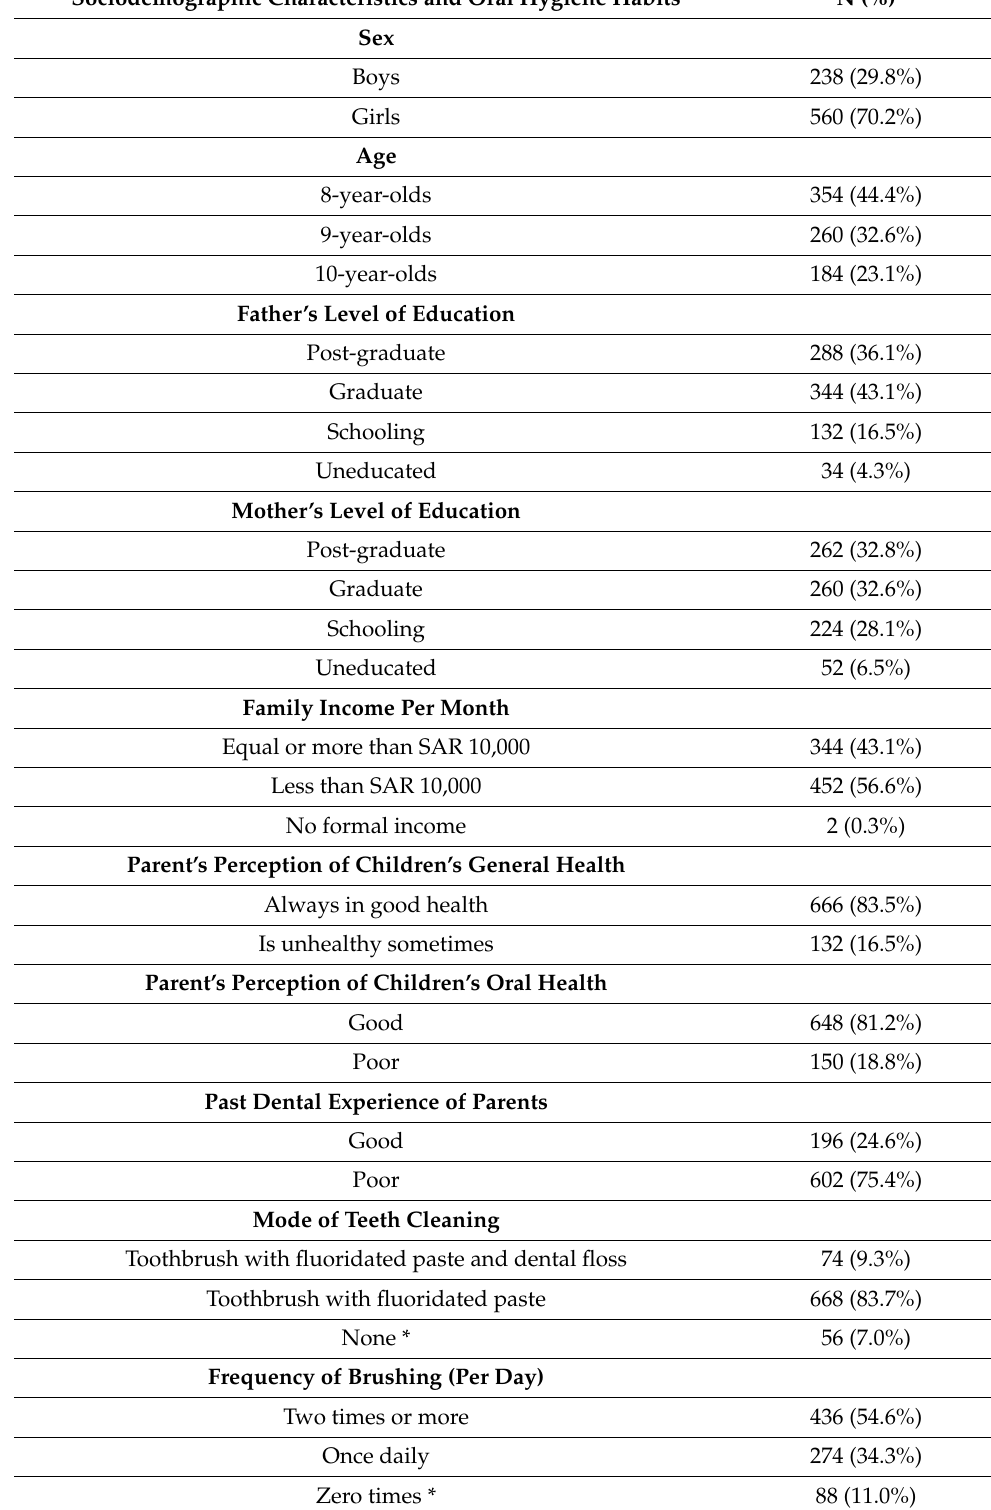
Table 1. Sociodemographic characteristics and oral hygiene habits of the study sample (N = 798). Sociodemographic Characteristics and Oral Hygiene